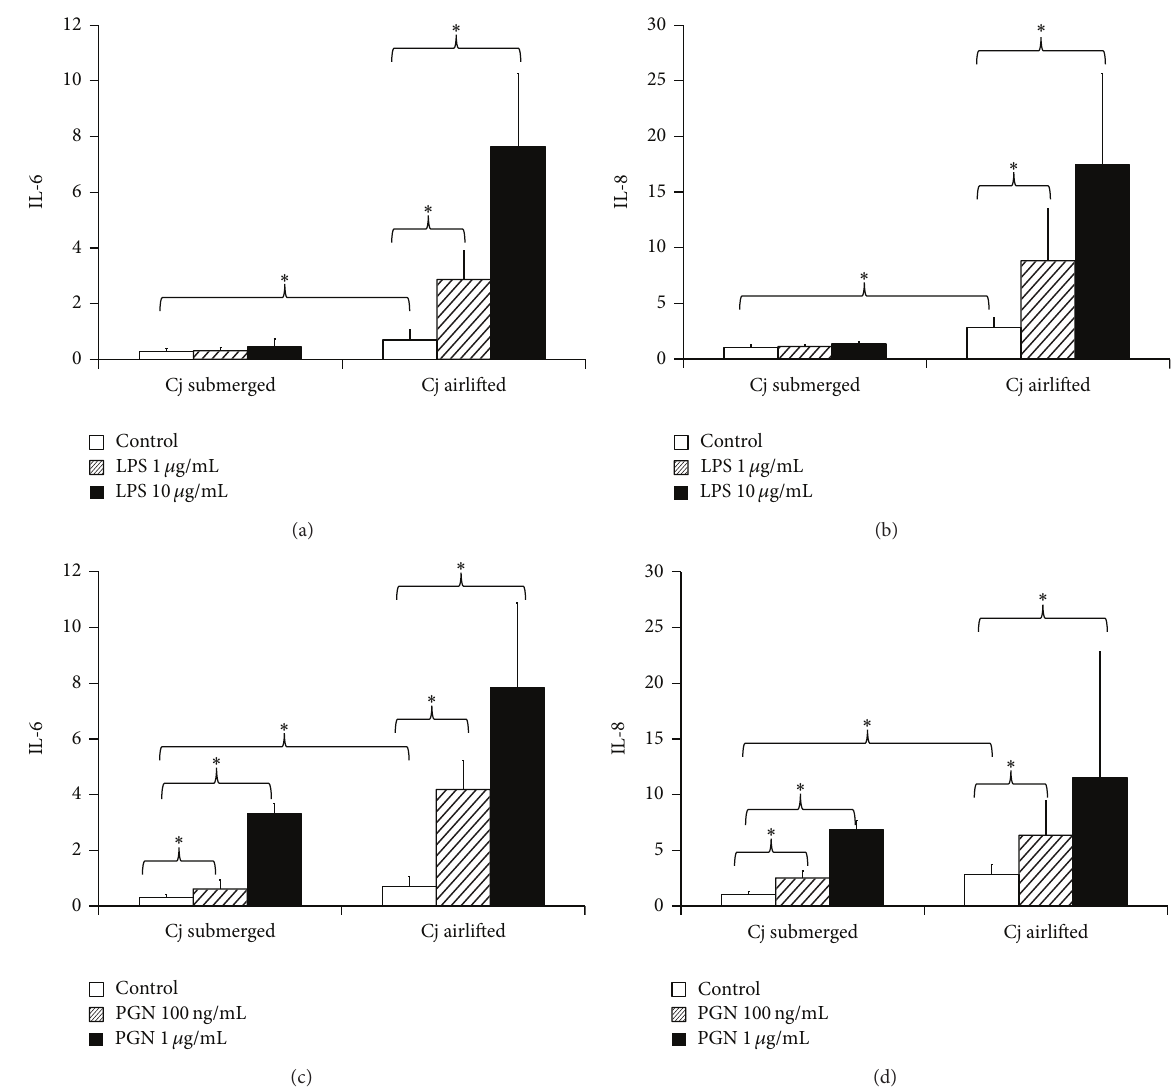
Figure 3: LPS and PGN stimulated IL-6 and IL-8 secretion in submerged and airlifted primary conjunctival epithelial cells. (a) LPS stimulated IL-6 secretion. (b) LPS stimulated IL-8 secretion. (c) PGN stimulated IL-6 secretion. (d) PGN stimulated IL-8 secretion. IL-6 and IL-8 concentrations were expressed as pg/mL medium/mg total cellular protein. Asterisks ( ∗ ) denote significant difference ( 𝑃 < 0.05 by paired 𝑡 -test) between two groups. 𝑌 error bars represent the standard deviation of the averaged results from 3 different experiments.